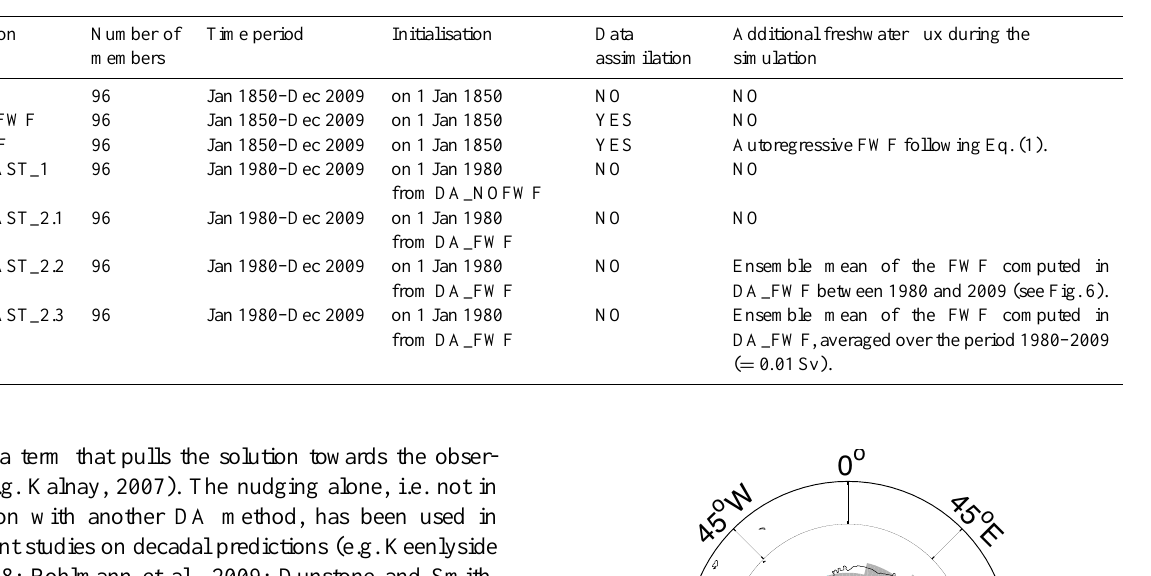
Table 1. Summary of the simulations analysed in this study.